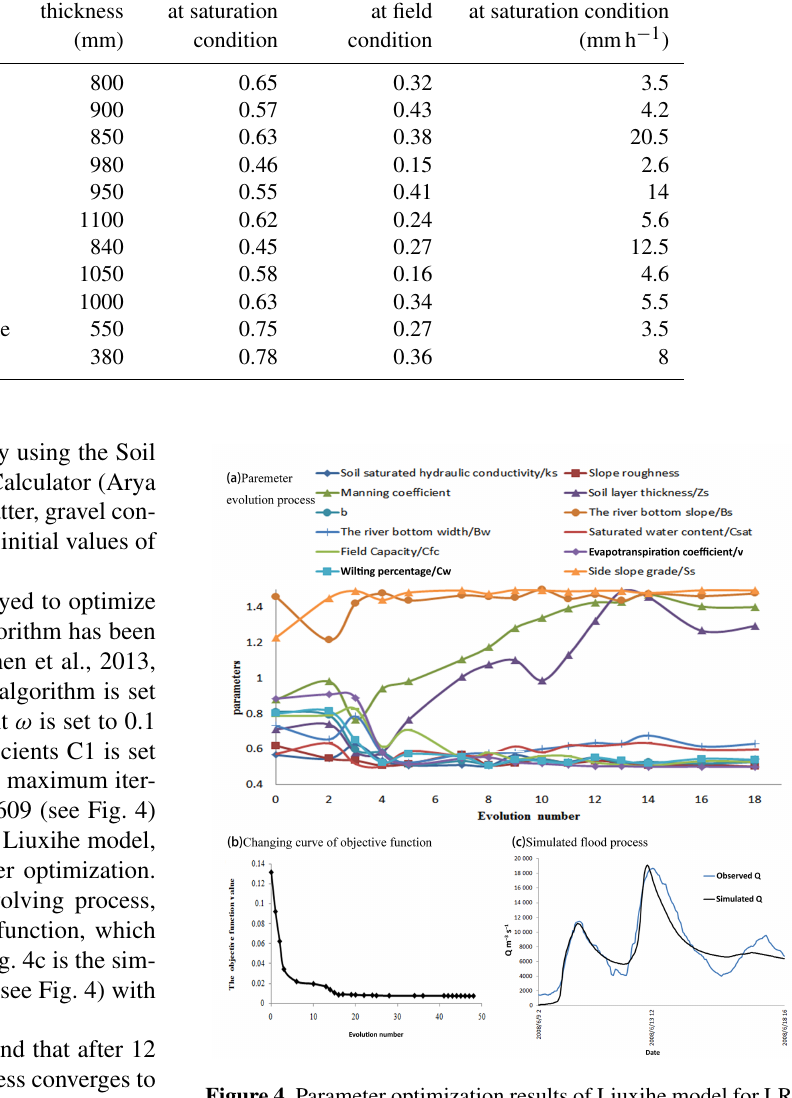
Table 3. The initial values of soil-related parameters. Soil type Soil Water content Water content Hydraulic conductivity thickness at saturation at field at saturation condition